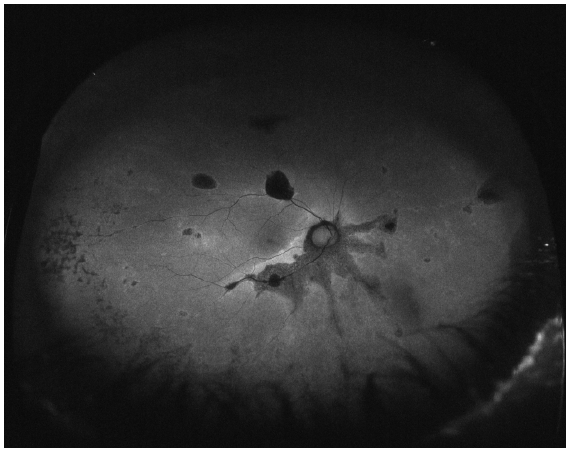
Figure 1: Autofluorescence image of the right eye showing hypoautofluorescence at the paravenous zone